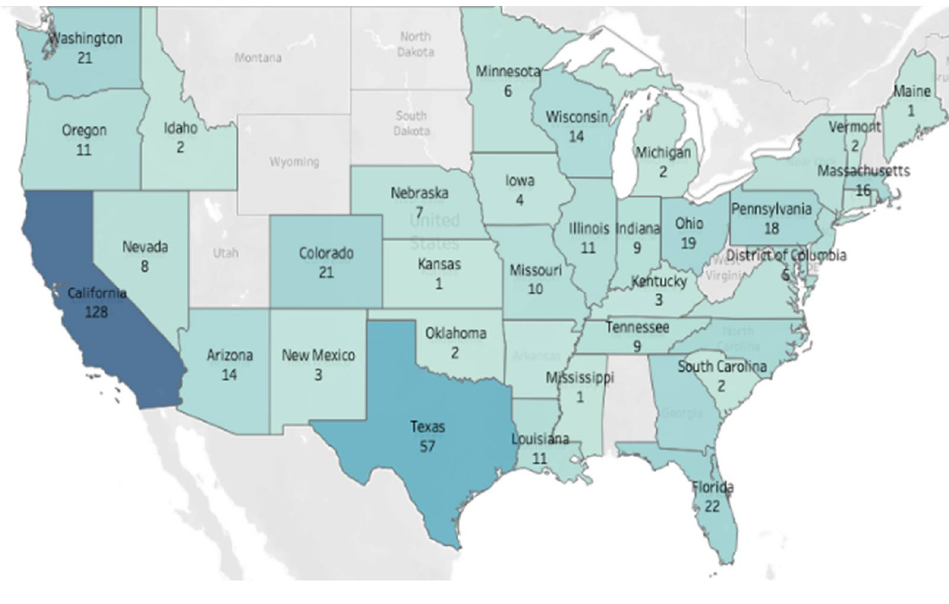
Figure 6. Housing Policy counts by State.